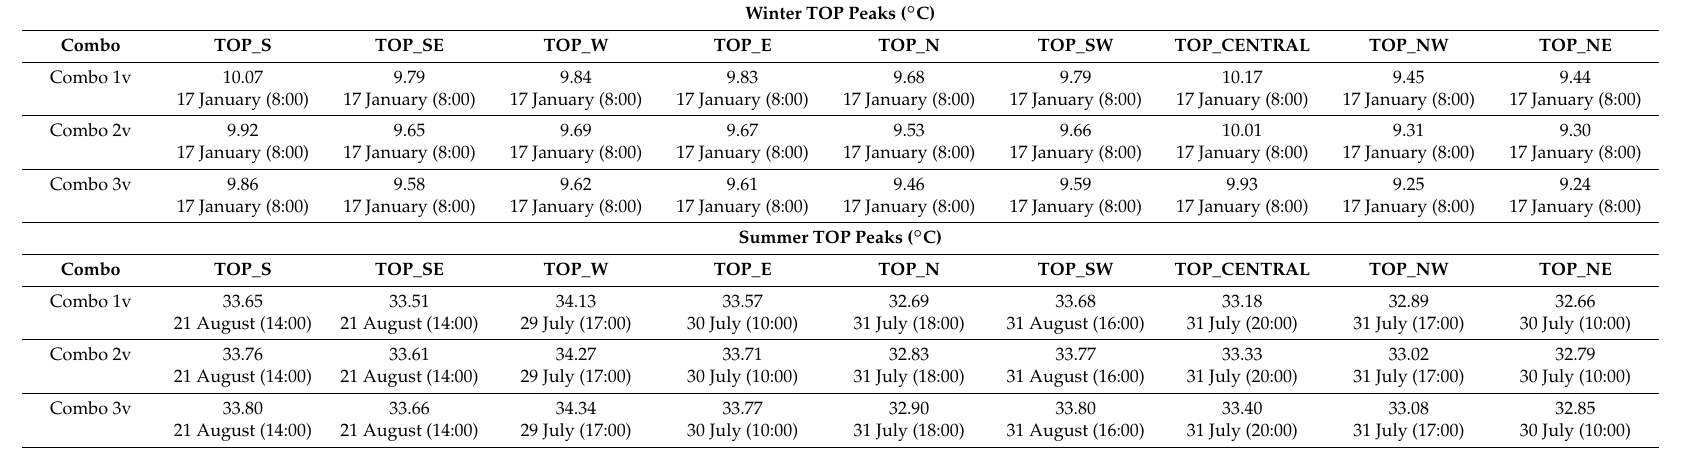
Table 9. Second step: TOP yearly